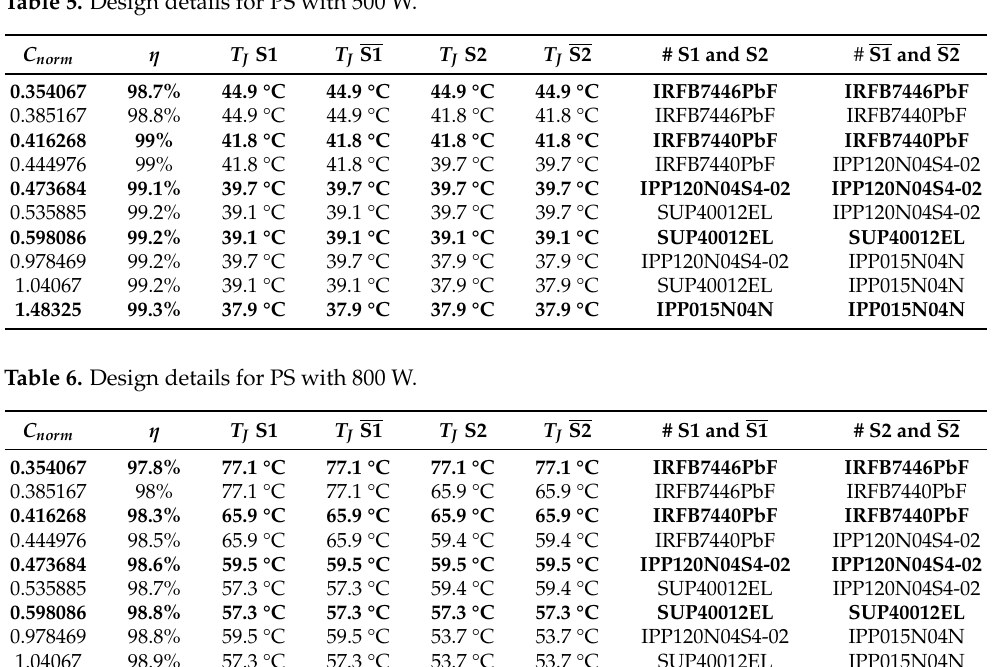
Table 5. Design details for PS with 500 W.